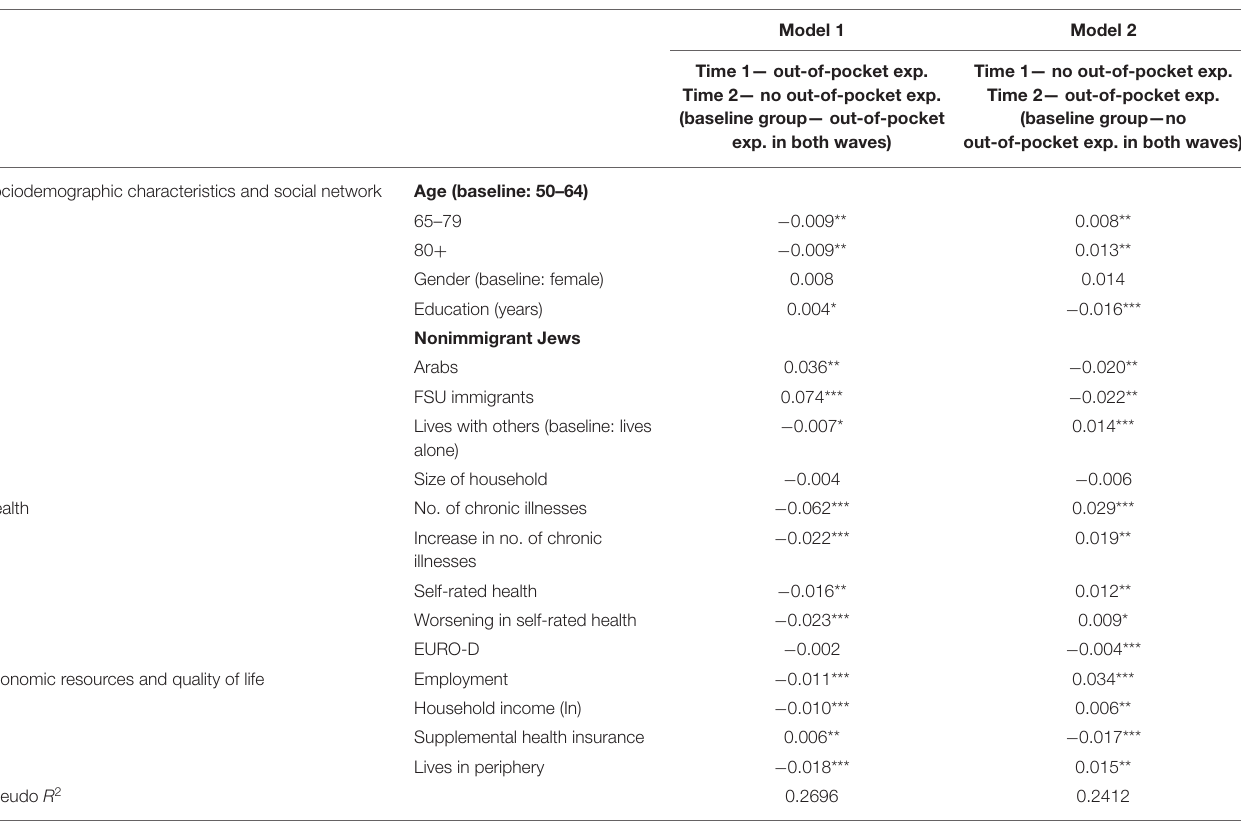
TABLE 6 | Multinomial models for transitions among situations of out-of-pocket expenditure on healthcare services among persons aged 50 + in investigation time 1 (marginal effect).